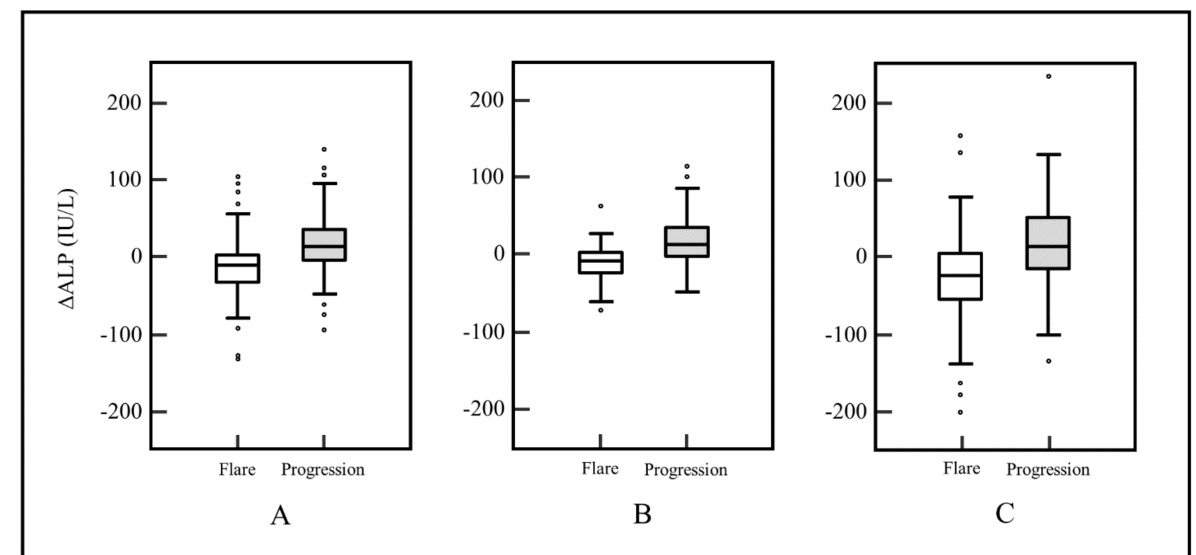
Figure 2. Comparison graphs for ∆ ALP between flare and progression groups. ∆ ALP was signif- icantly lower in the flare group than in the progression group. Median ∆ ALP was ( A ) − 11 and 15 IU/L ( p < 0.0001), respectively, in all patients; ( B ) − 7 and 15 IU/L ( p < 0.0001), respectively, in breast cancer patients; and ( C ) − 23 and 15 IU/L ( p = 0.0083), respectively, in prostate cancer patients.